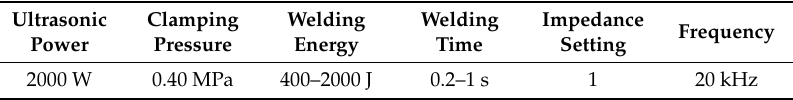
Table 2. Welding parameters selected in the present